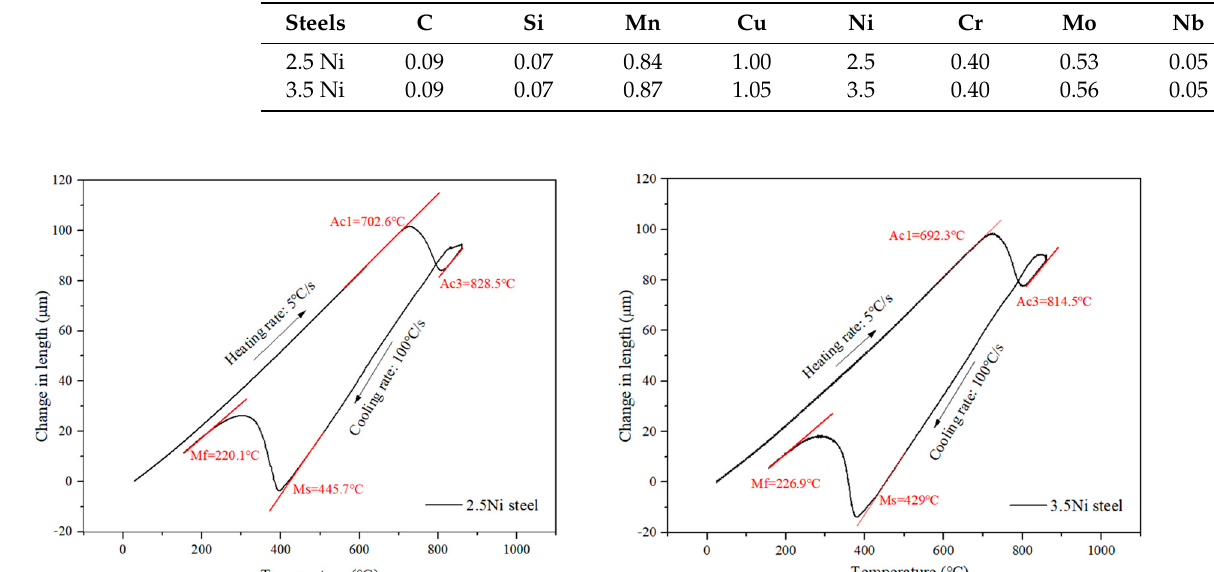
Table 1. Composition of the two investigated steels (wt.%).